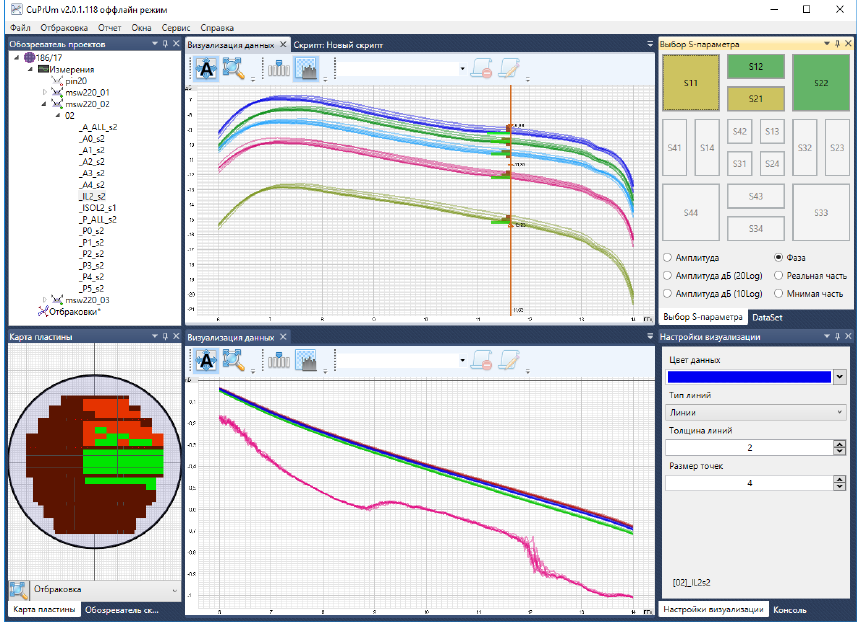
Fig. 5. CuPrUm user